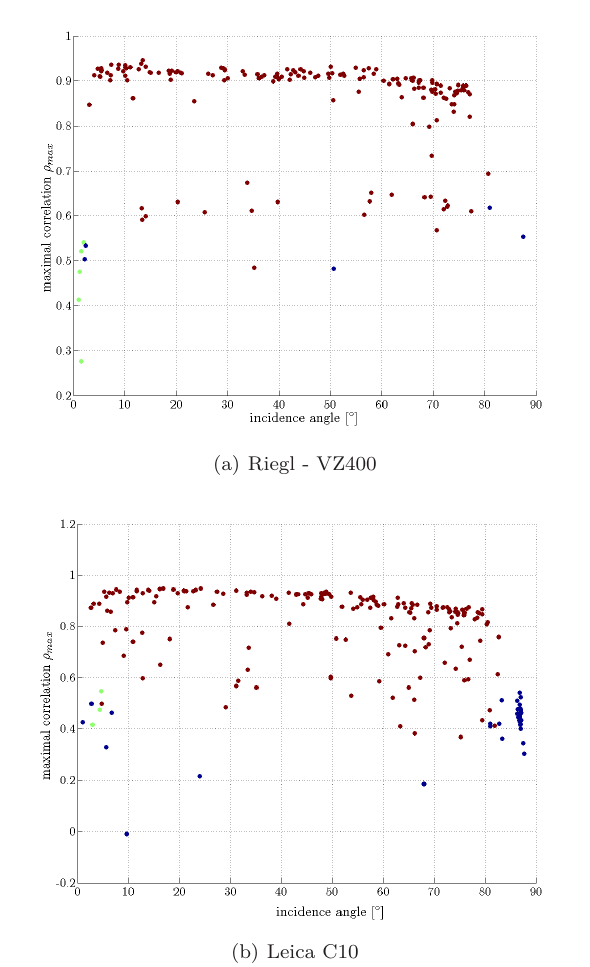
Figure 5: Correctness of results